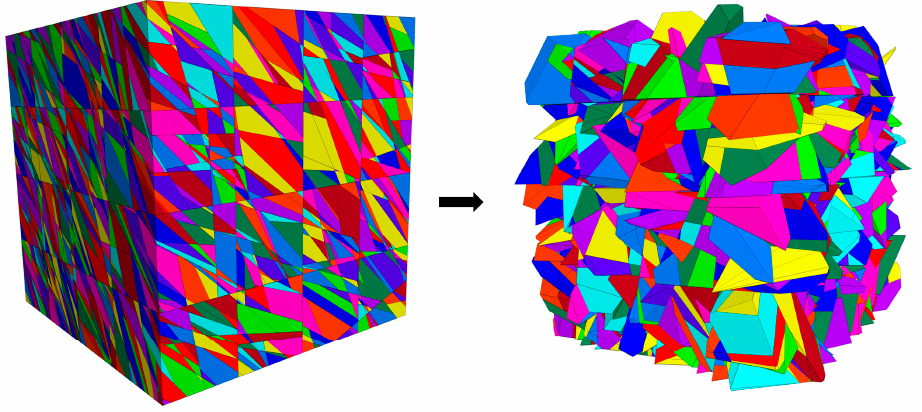
Figure 10. Three-dimensional (3D) rock block model based on the stochastic DFN simulation before and after excluding the boundary blocks.